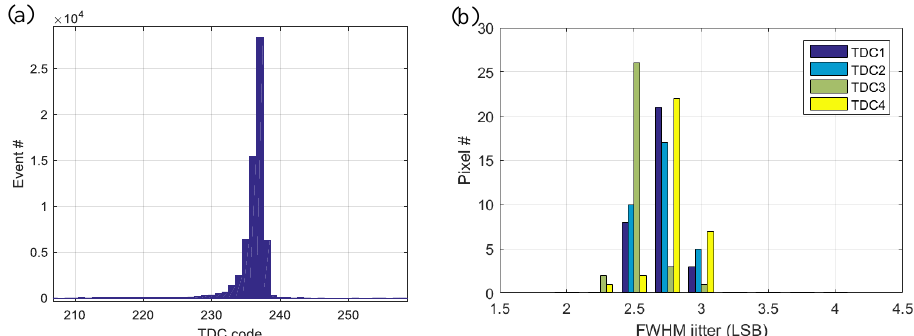
Figure 14. ( a ) Single shot SPAD-TDC timing jitter measurement with a minimum FWHM of 2.28 LSB ( b ) jitter distribution of all the pixels at each TDC measurement, leading to the average and standard deviation of 2.68 LSB and 0.15 LSB, respectively.